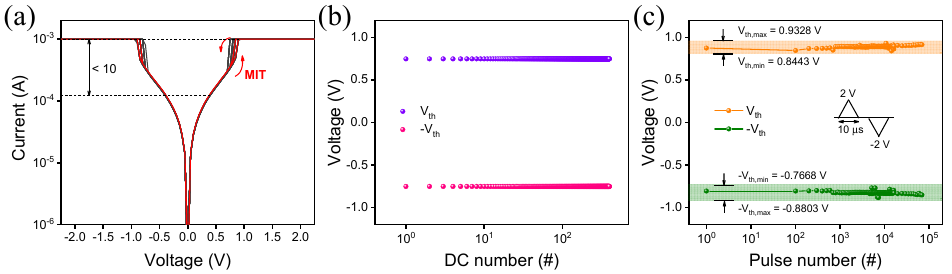
Figure 4. ( a ) I − V curve of MIT characteristics. The endurance test: ( b ) DC sweep and ( c ) pulse mode.